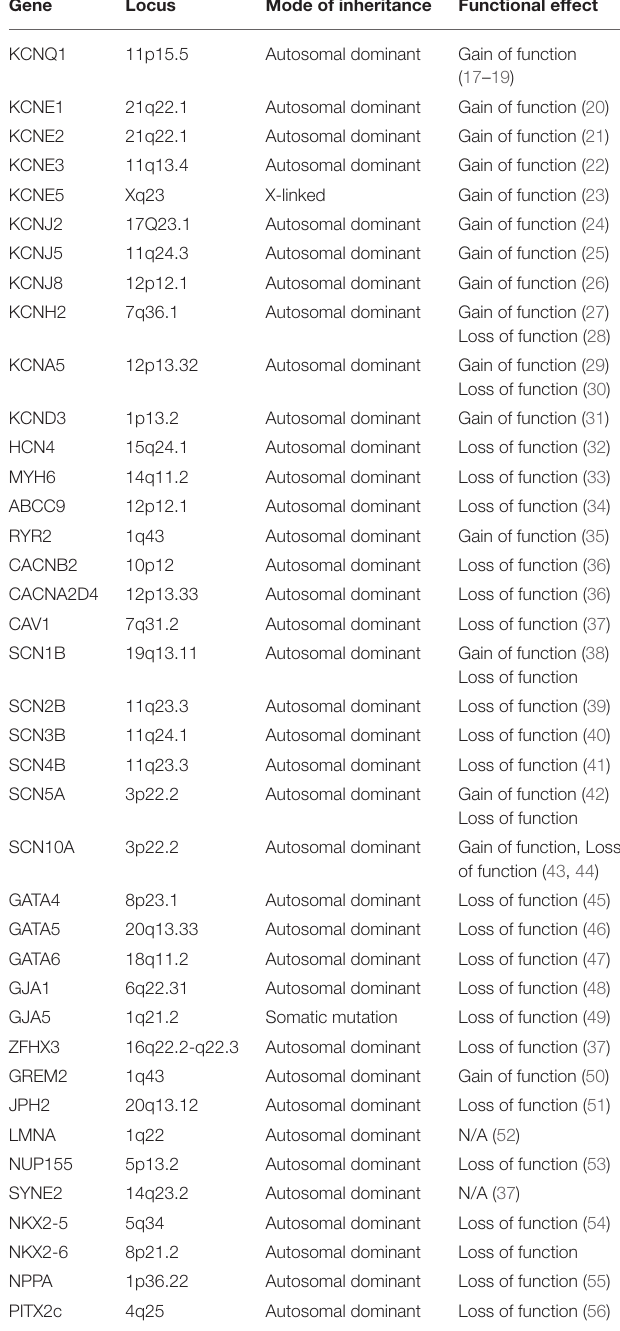
TABLE 1 | Summary of gene loci associated with familial atrial